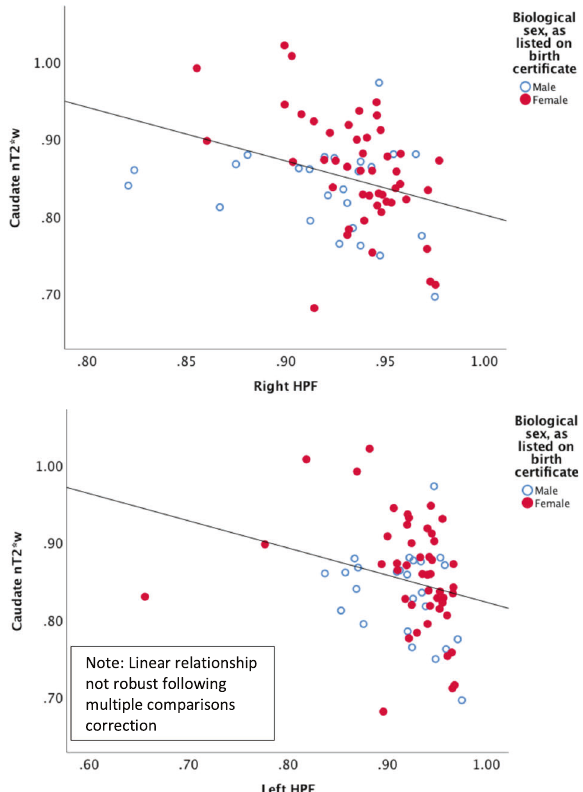
Fig. 3 Scatterplots depicting the nature of correlational relation- ships between normalized T2*-weighted (nT2*w) signal in the caudate and Hippocampal Parachymal Fraction (HPF) in the right and left hippocampus, as reported in Table 2. For nT2*w signal, higher values indicate lower tissue iron concentration; for HPF, higher values indicate increased hippocampal integrity (e.g., less atrophy). Sex differences in nT2*w are simultaneously illustrated through individual points for female (red, fi lled) and male (blue, hollow)